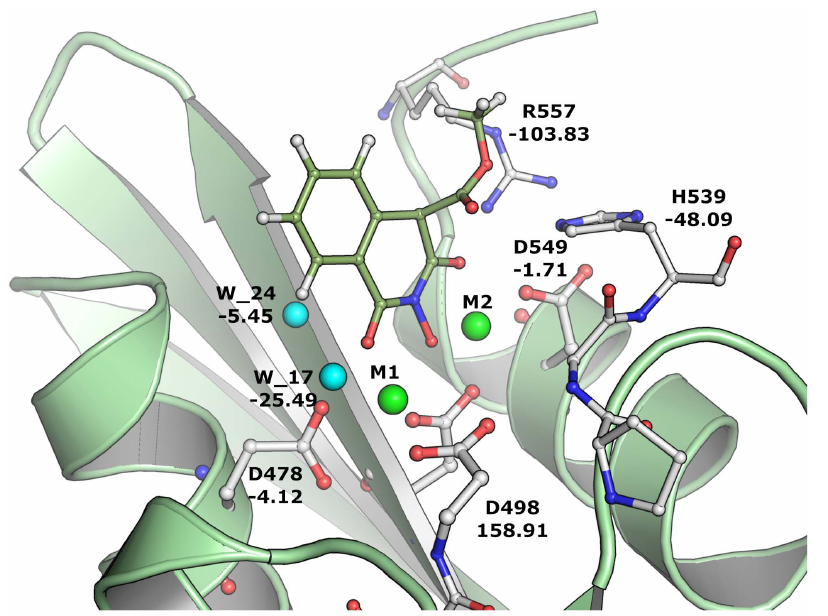
Figure 4. Binding mode of HIQ20 at RNH active site. Binding pose of HIQ20 at the RNase H catalytic site with important residues including water molecules (cyan sphere) and magnesium ions (green sphere). Energy contribution due to each residue is shown in kcal/mol based on the FMO calculation.